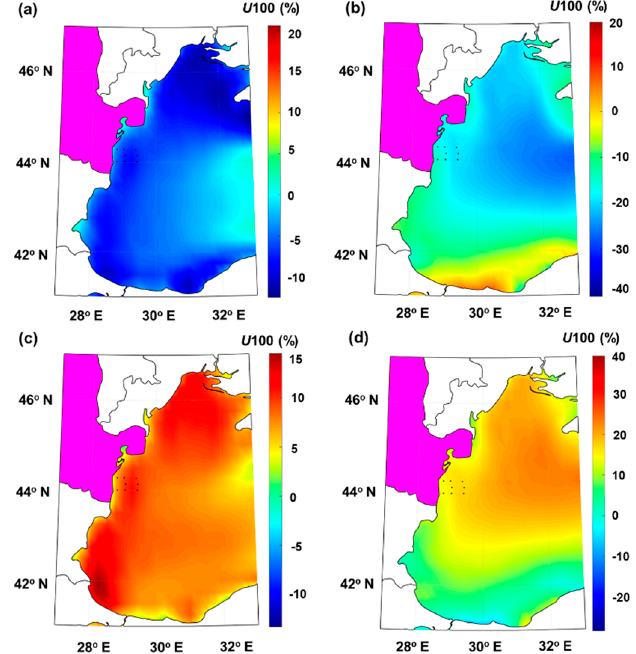
Figure 7. The spatial differences (in %) between the total time data and the main seasons. Results for the U 100 parameter (average values) considering the 20-year time interval of ERA5 data, where: ( a ) spring; ( b ) summer; ( c ) autumn; ( d ) winter.